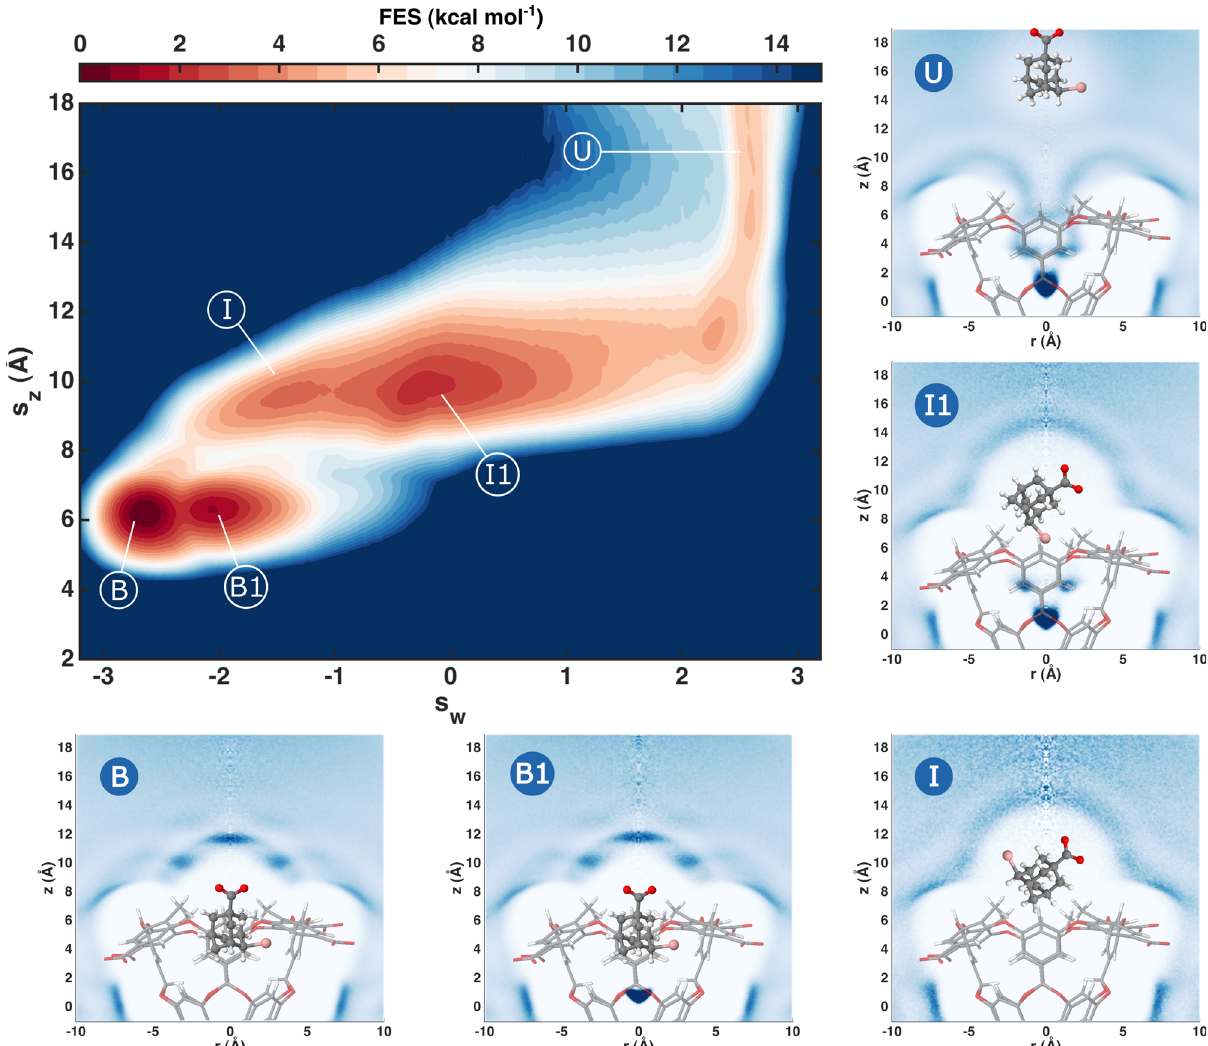
Fig. 5 Binding FES of ligand G4 with a study of the water presence in the visited states. We show the two-dimensional FES of the ligand G4 with respect to s z and Deep-LDA CV s w . Different adjacent colours correspond to a free energy difference of 1 k B T ≈ 0.6 kcal mol − 1 . We highlight some relevant states over which we perform plain molecular dynamics (MD) simulations to measure the presence of water. We show histograms of the water oxygen atoms ’ density in cylindrical coordinates z , r . Each histogram is normalised by the density value in its top-right corner and darker colours correspond to higher- water-density regions. The position of the ligand in these plots is